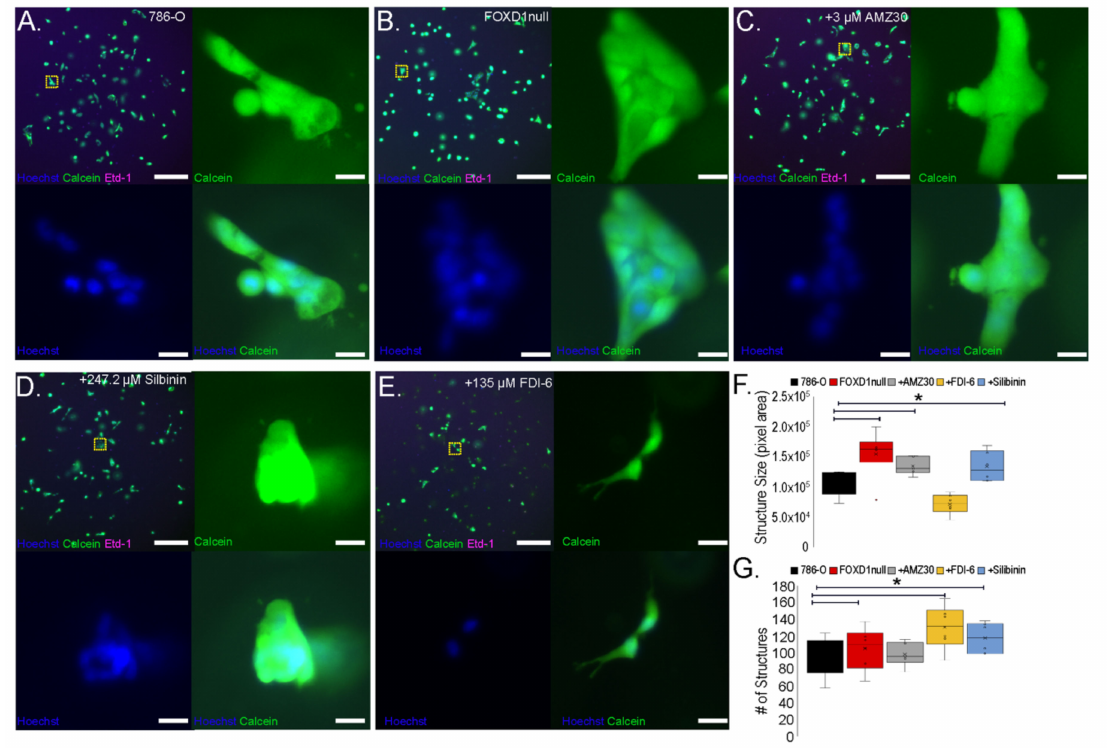
Figure 6. Effects of candidate compounds on 3D growth of 786-O tumor cells. ( A – E ) the 786-O 3D cultures were treated with specified compounds and allowed to grow for three days. Three- dimensional cultures were then stained for nuclei (Hoechst 33342 (blue)), viability (Calcein-AM (green)), and death (Ethidium homodimer-1 (magenta)). Upper left panels are widefield images (scalebar = 500 microns). Upper right, bottom left, and bottom right panels show split channels of representative cell colonies outlined in the widefield image (yellow box). The scalebar for higher magnification images is 20 microns. ( F ) the size distribution of Calcein-AM + cell colonies was quantified. * = p -value < 0.05 calculated by Z-test. ( G ) The total number of Calcein-AM + cell colonies in each culture was quantified. * = p -value < 0.05 calculated by Z-test. X = median, line through box =